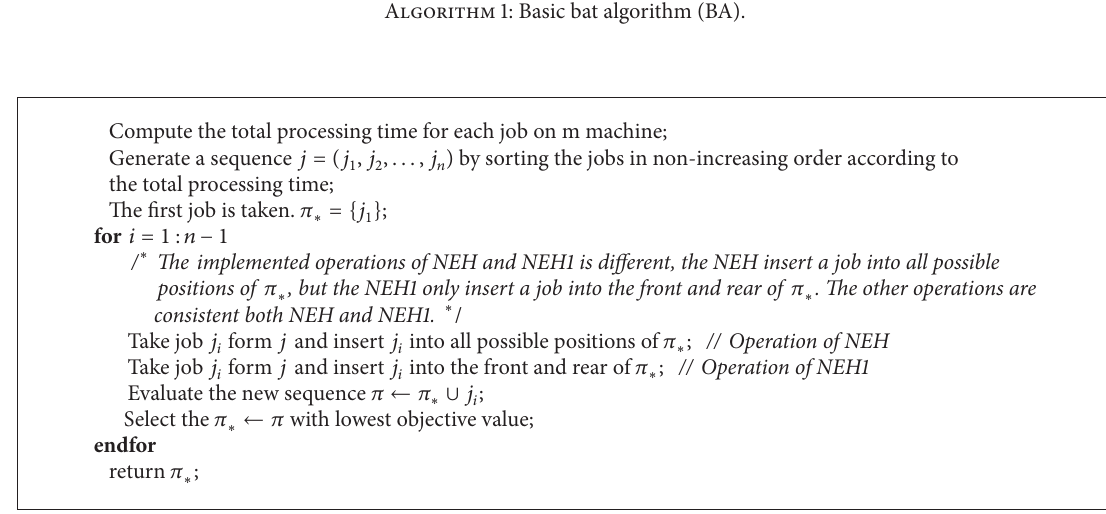
Algorithm 2: The pseudocode of NEH and NEH1.